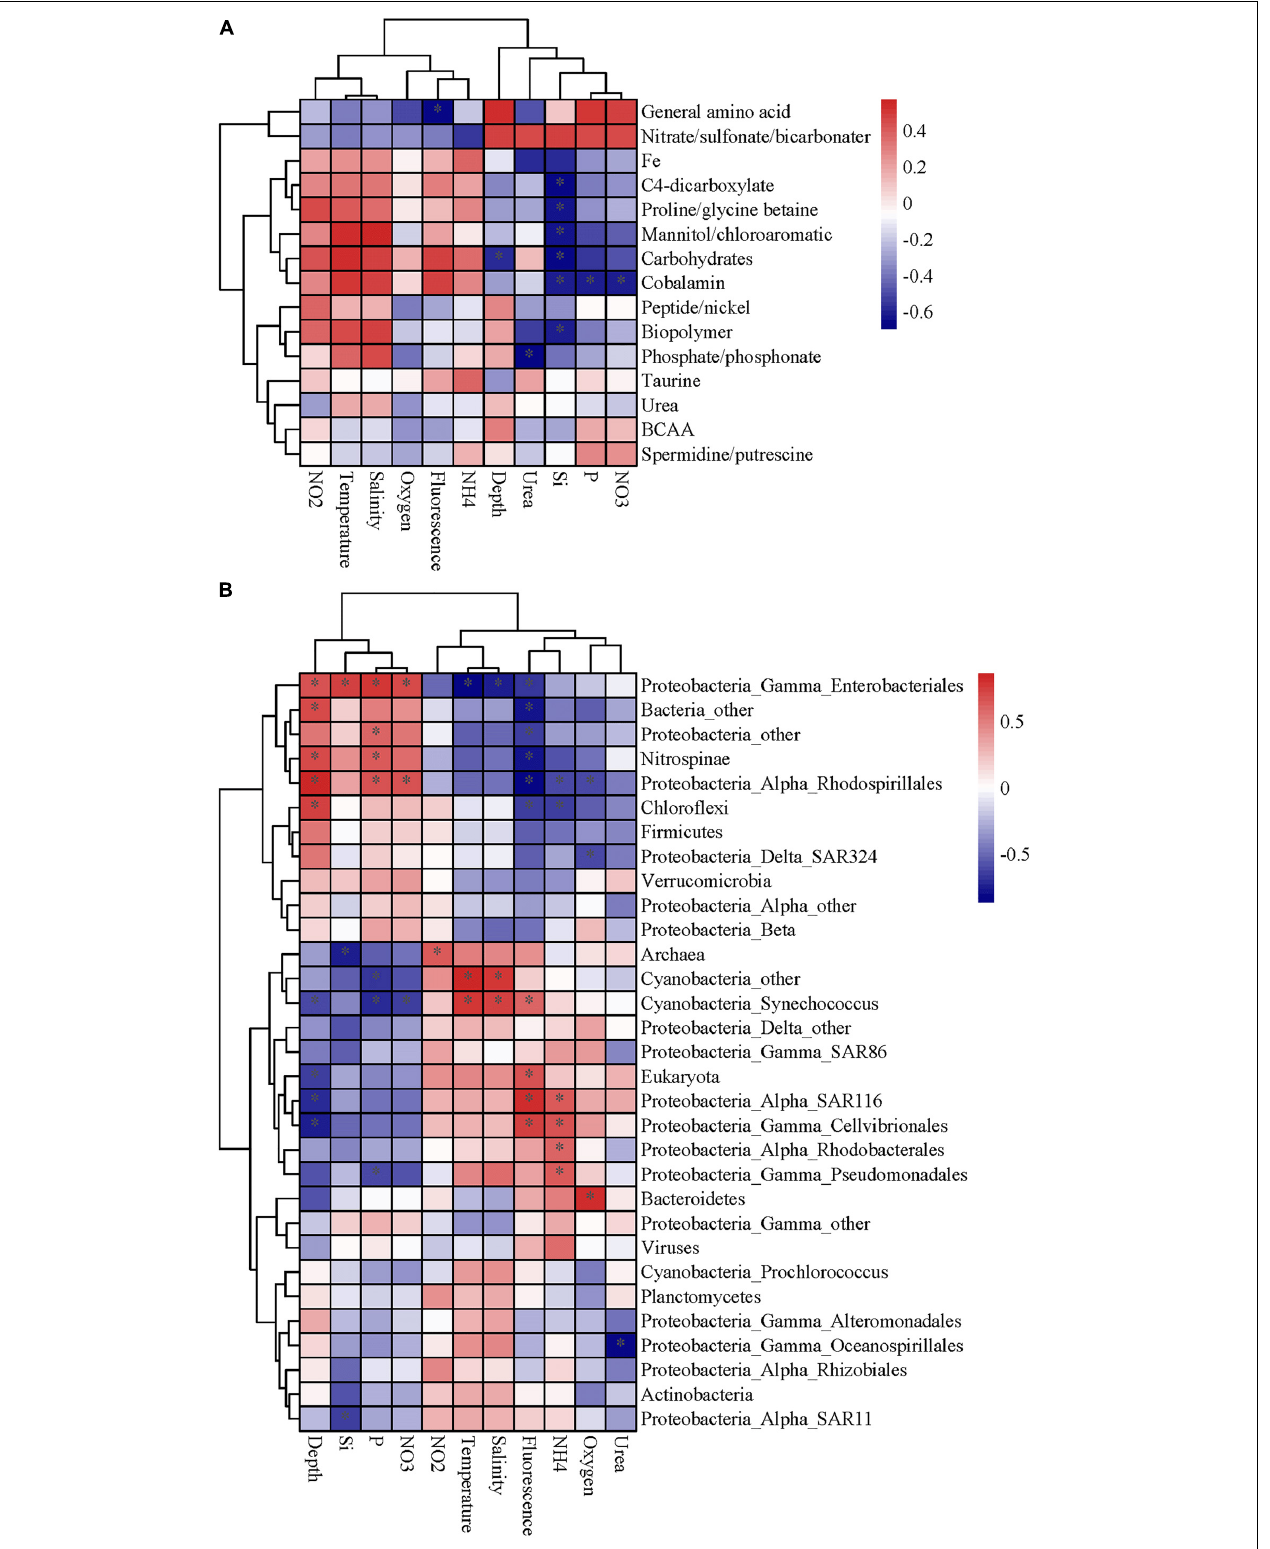
FIGURE 3 | The Spearman correlation analysis was performed to determine the correlation between environmental factor and substrate or microbial community. (A) The correlations between substrates and environmental factors. (B) The correlations between substrate-active community and environmental factor. The fluorescence represented chlorophyll fluorescence. The color of the boxes show the correlation coefficient. The “*” represents statistical significance with p ≤ 0.05.